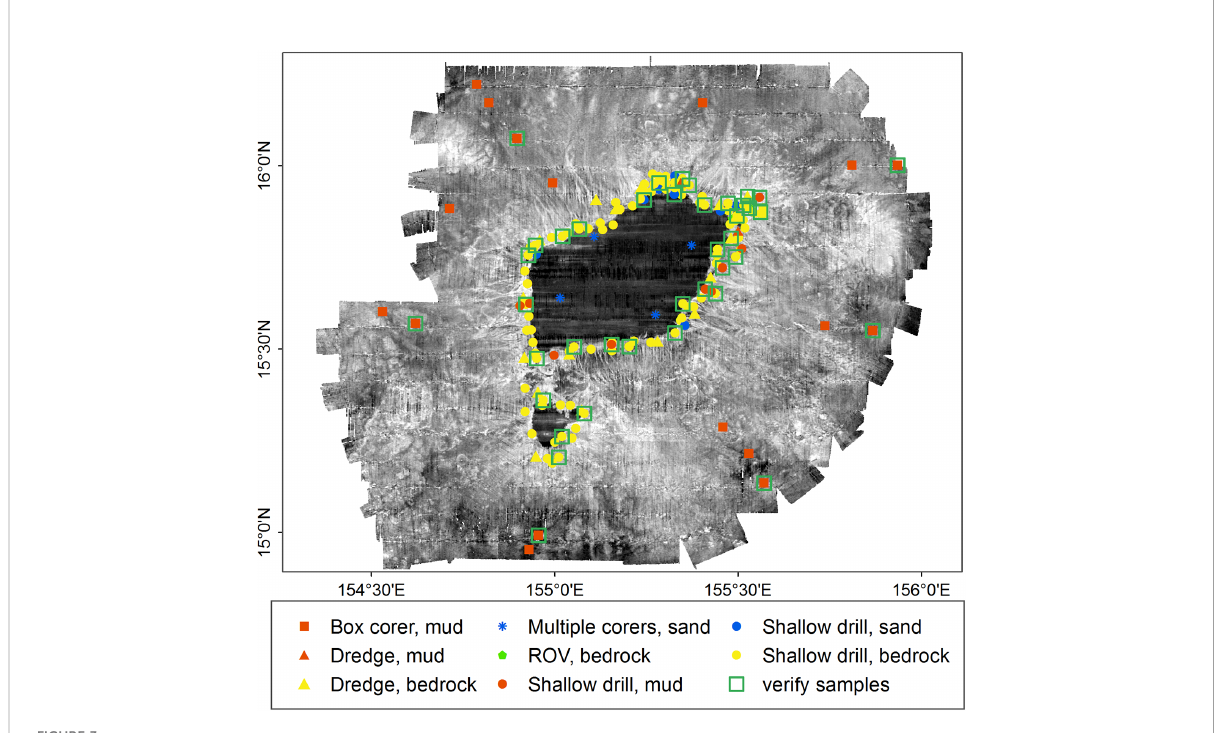
FIGURE 3 Backscatter mosaic image and ground-truth sampling